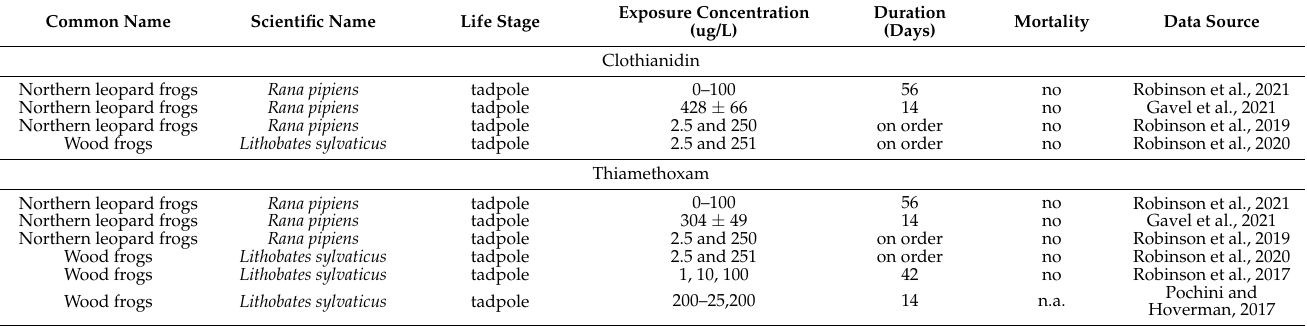
Table 5. Compilation of results on amphibian survival after exposure to clothianidin or thiamethoxam 1